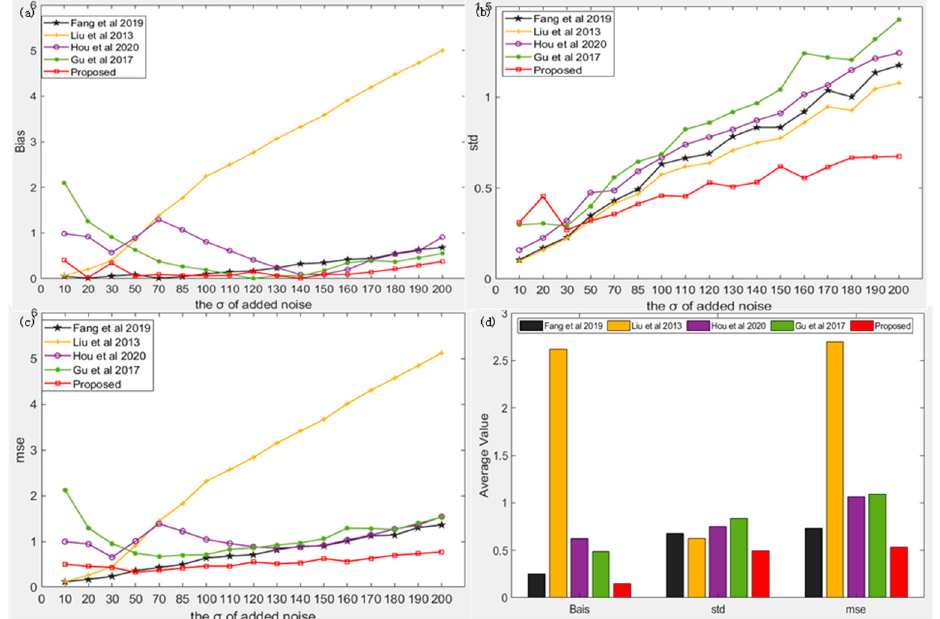
Figure 4. Comparison of the results of our algorithm and four existing algorithms [34,36,38,49] under TID2013 dataset. ( a ) the bias of noise estimation results of five algorithm under different noise levels, ( b ) the std of noise estimation results of five algorithm under different noise levels, ( c ) the mse of noise estimation results of five algorithm under different noise levels, ( d ) the average value of noise estimation results of five algorithm under different noise levels.